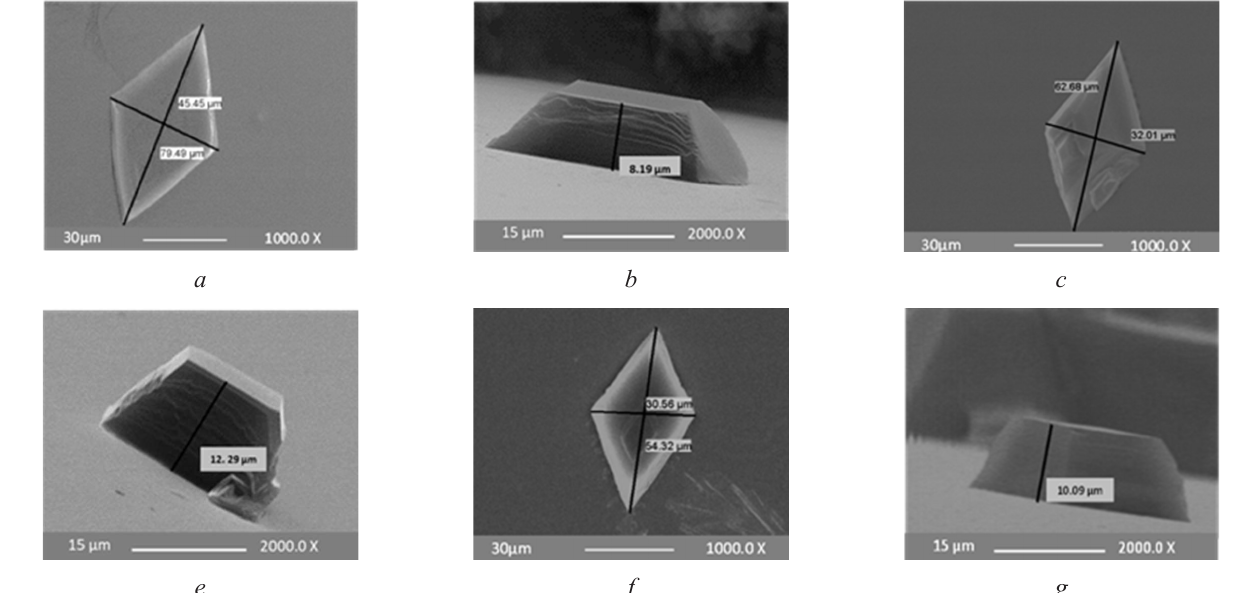
Fig. 2. Length, width, and thickness measurements of MDN crystals: a, c, e – SEM images of aerial views for MDN